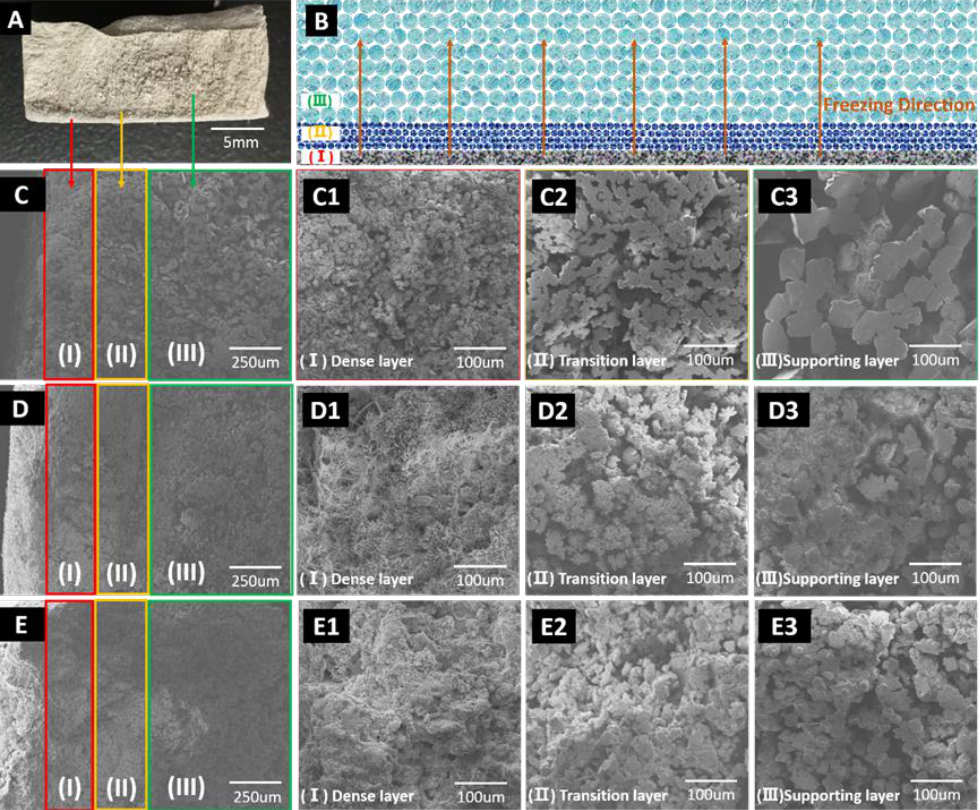
Figure 2. Typical PCM sample and micromorphology characterization. The overall image of PCM ( A , C – E ); the illustration of membrane cross-sectional microstructure ( B ); the SEM images of the gradient-pore-morphology of dense layer ( C1 – E1 ), transition layer ( C2 – E2 ) and supporting layer ( C3 – E3 ). The SEM images of PCMs with solid content at 40 wt.% ( C , C1 – C3 ), 50 wt.% ( D , D1 – D3 ) and 60 wt.% ( E , E1 – E3 ). Table 1. Influence of solid content on the performance and pore structure of